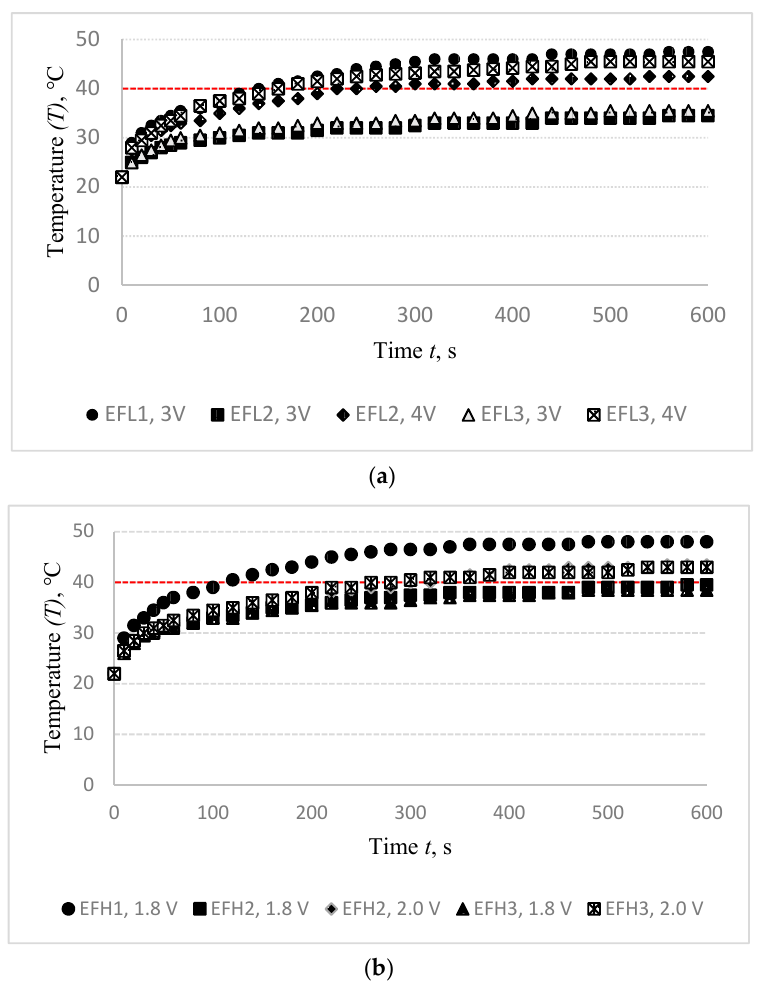
Figure 4. Target temperature observation of designed specimens of EFL group ( a ) and EFH group ( b ) during the 600 s period by applying different voltages.